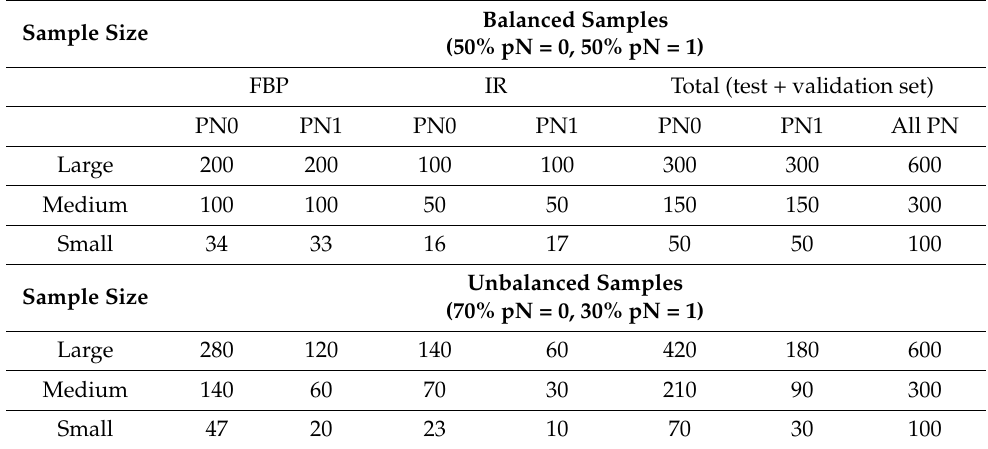
Table 1. Summary of the simulated samples included in the analysis as combinations of three sample sizes ( N = 600, 300 and 100), balanced/unbalanced and high/low signal *.